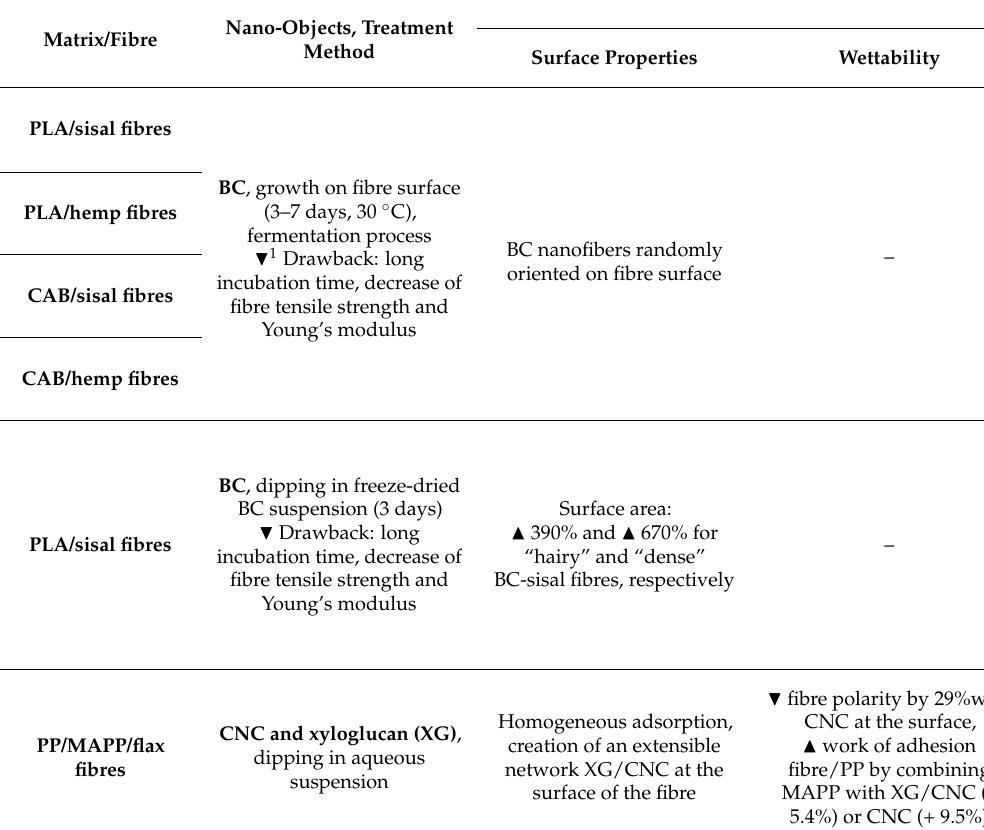
Table 3. Hierarchical biocomposites reinforced with bio-based nanoparticle modified natural fibres: characteristics and